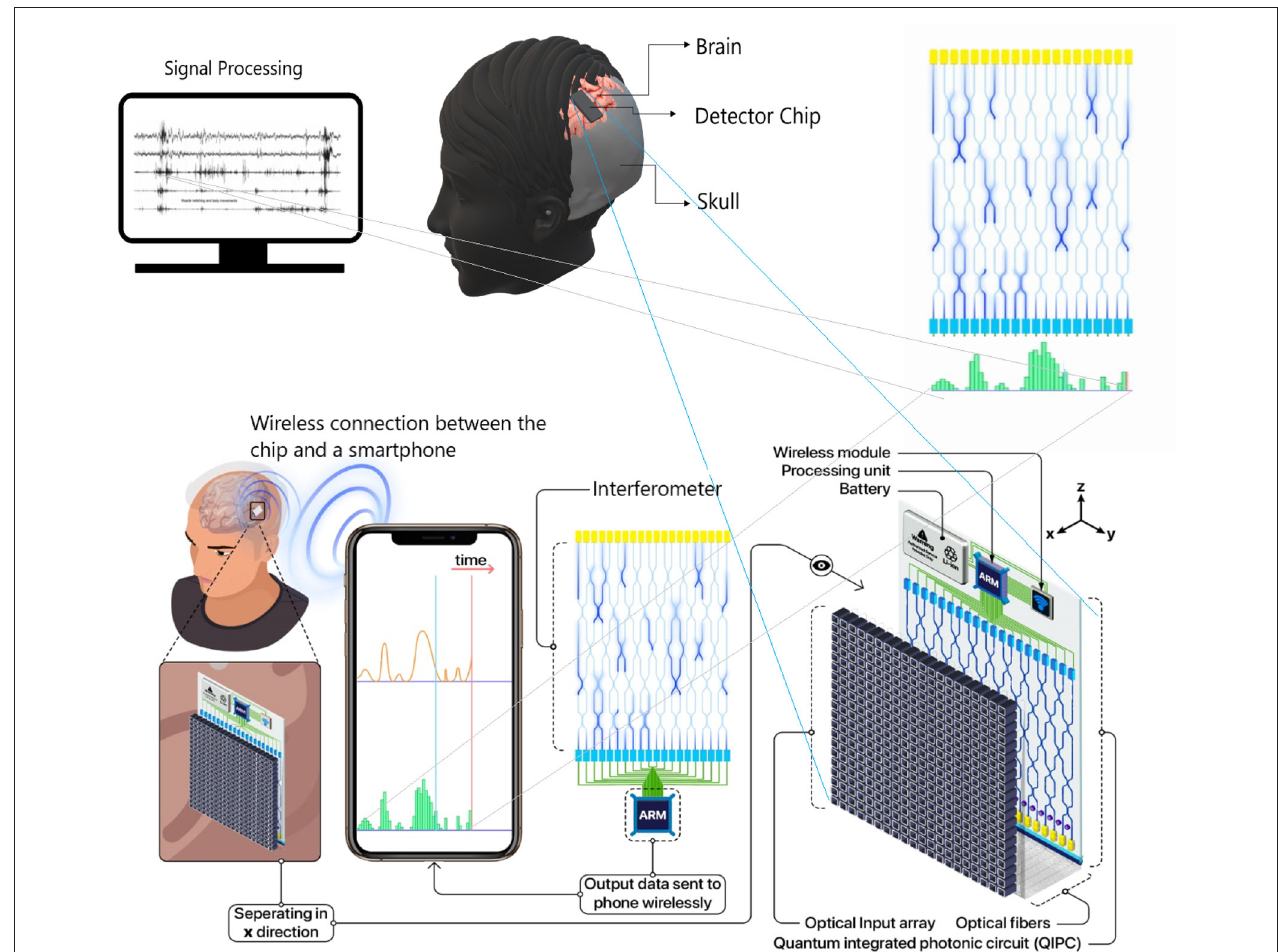
FIGURE 2 | In a brain–computer interface (BCI) proposal, an optical chip is implanted on the interior surface of the skull. A few number of ultraweak photon emission (UPE) photons interfere in a photonic chip and the results are detected as different single photon distributions at detectors vs. time. This results are communicated via wireless signals from the detector part of the chip to a receiver (e.g., smartphone or a